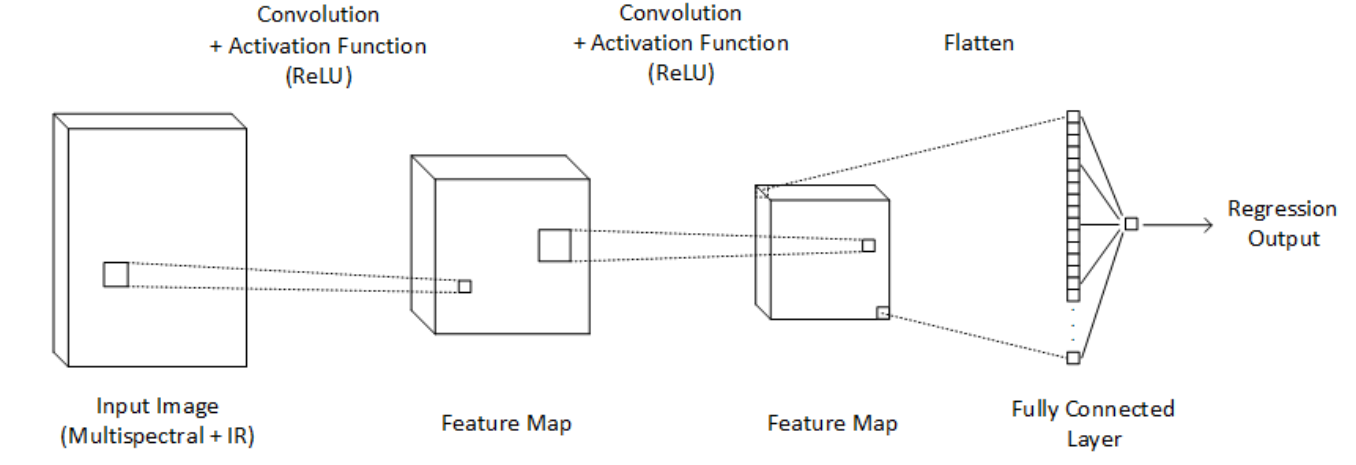
Figure 6. Soil moisture retrieval model using a convolutional neural